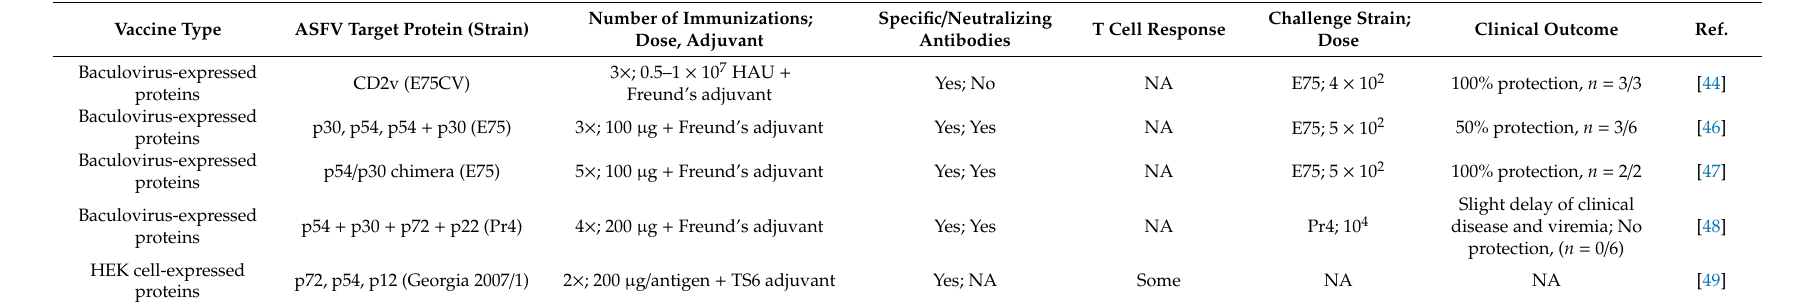
Table 1. Antigen-based African swine fever virus (ASFV) vaccines evaluated in the swine